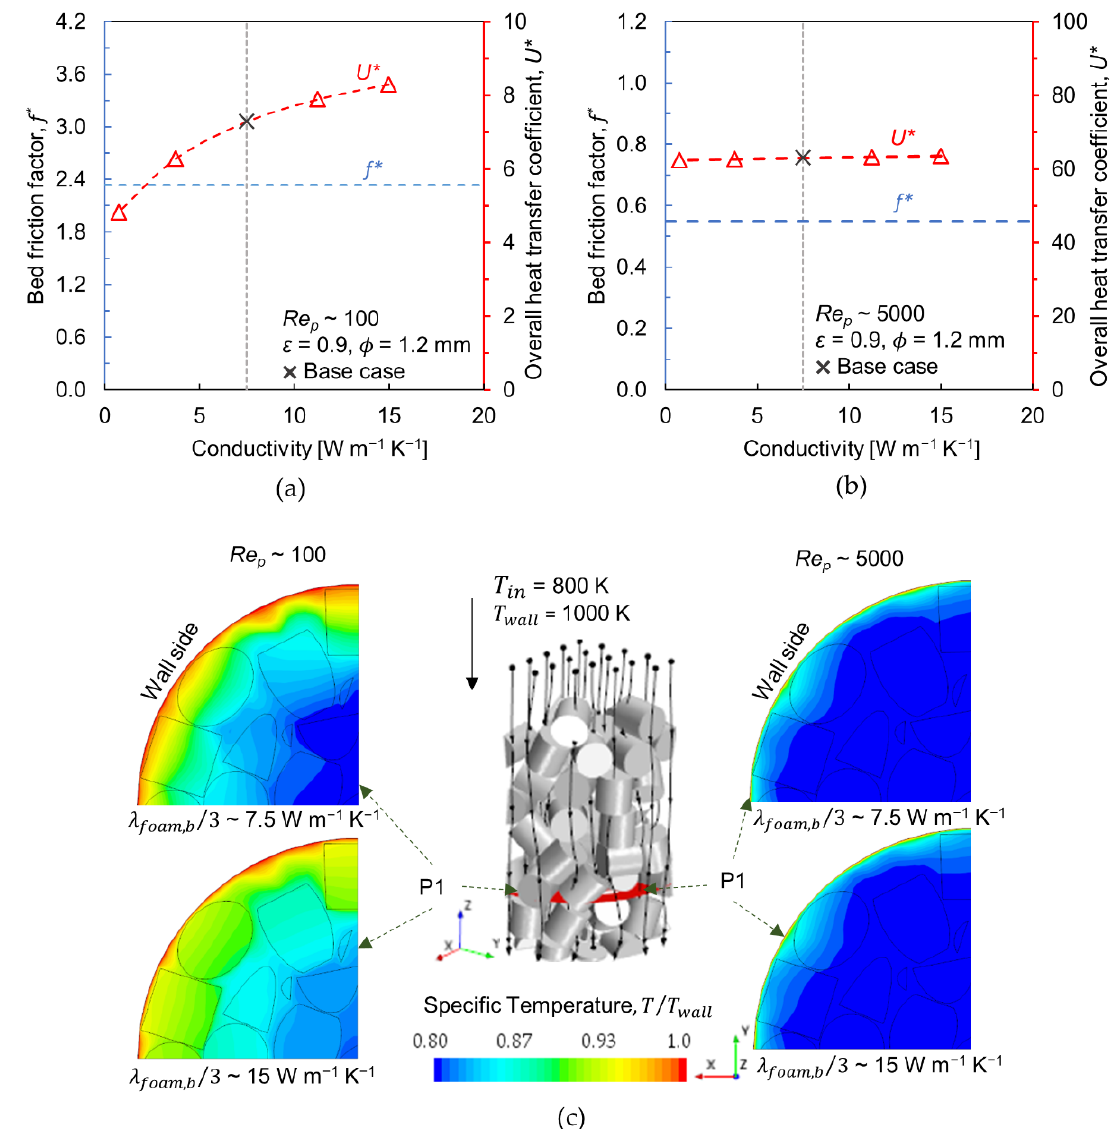
Figure 7. ( a , b ) Bed friction factor (left y -axis, circle markers) and overall heat transfer coefficient (right y -axis, triangle markers) versus foam conductivity at Re p ~100 and 5000, respectively (base case is 1/3 · λ foam , b —Equation (18); ( c ) Normalized temperature contours at Re p ~100 (left) and Re p ~5000 (right) for conductivities 0.75 W m − 1 K − 1 and 15 W m − 1 K − 1 (P1 is the cross-sectional plane where the velocity contours are shown, stream lines through the bed are represented by black lines with arrow heads).